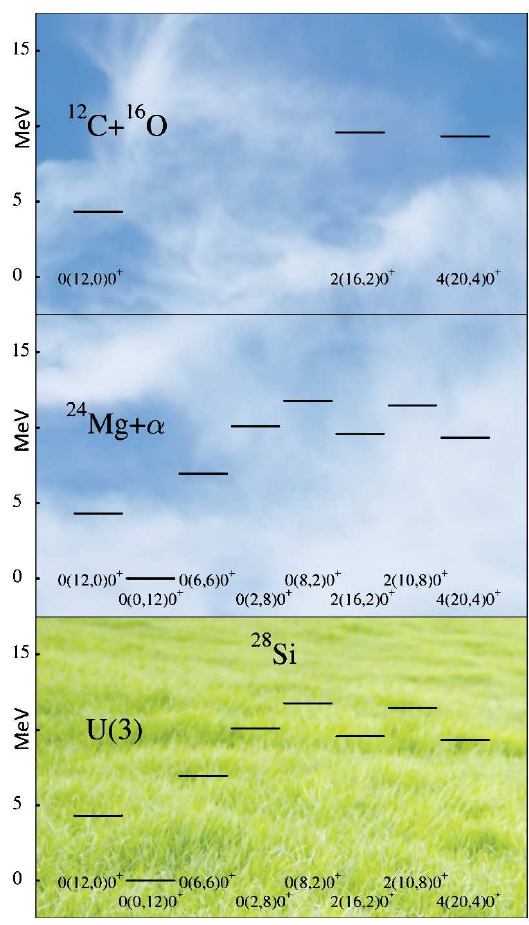
Figure 3. (Color online) The 0 + spectrum of 28 Si nucleus from the quartet model (lower part), and the 0 + states of two cluster configurations, predicted by the MUSY (upper parts).